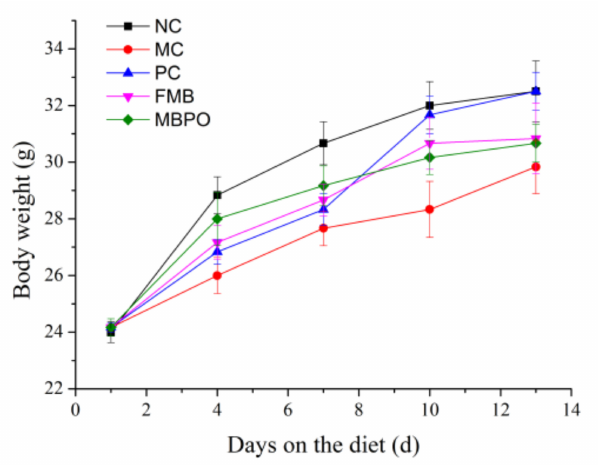
Figure 4. Body weight changes of mice in each group during the